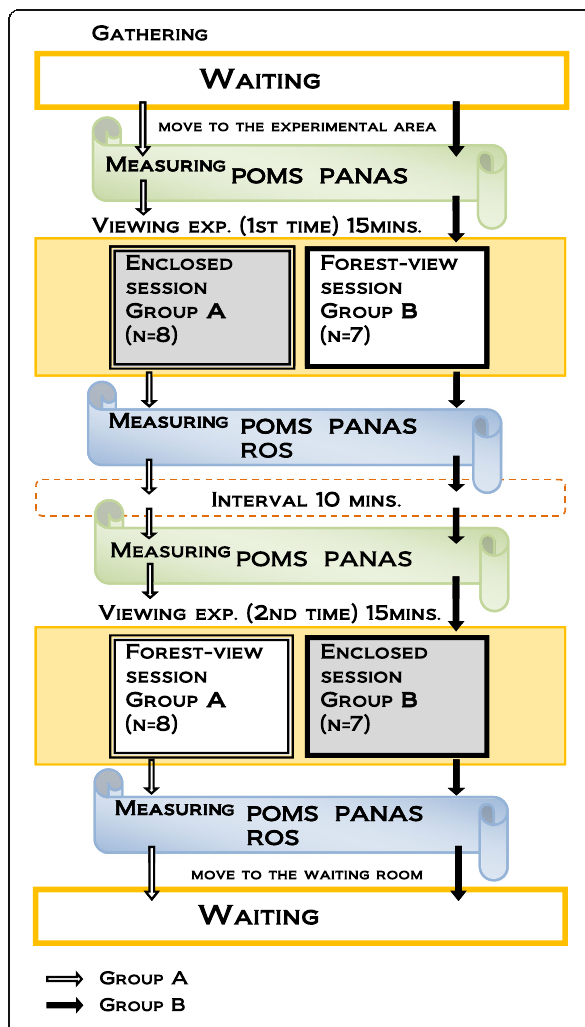
Fig. 5 Experimental procedure. The same experimental procedure was used in the May (unthinned) and October (thinned) experiments. Only the results of the forest view session were used in the analysis (for both May and October); the data from the enclosed sessions were not